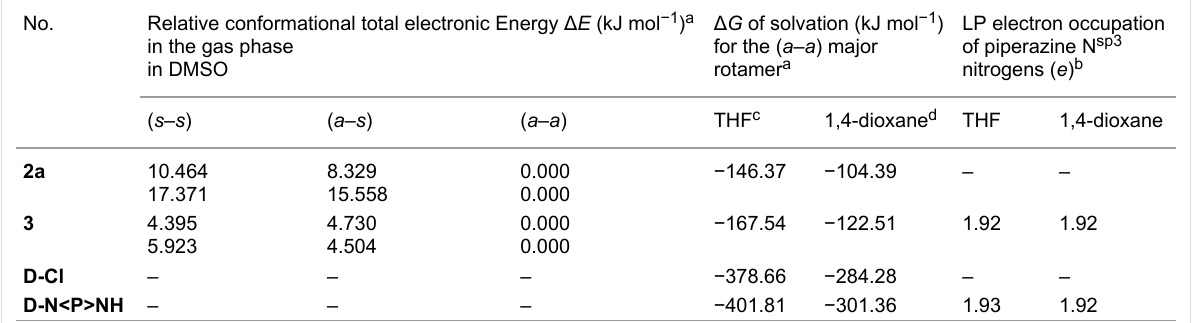
Table 2: Full geometry optimisation of G-0 dendrons 2a , 3 [51-54], solvation energies of G-0 and G-1 dendrons 2a , 3 , D-Cl , D-N<P>NH [54] and lone pair (LP) electron occupation of piperazine N sp3 nitrogens in dendrons 3 and D-N<P>NH [56,57].